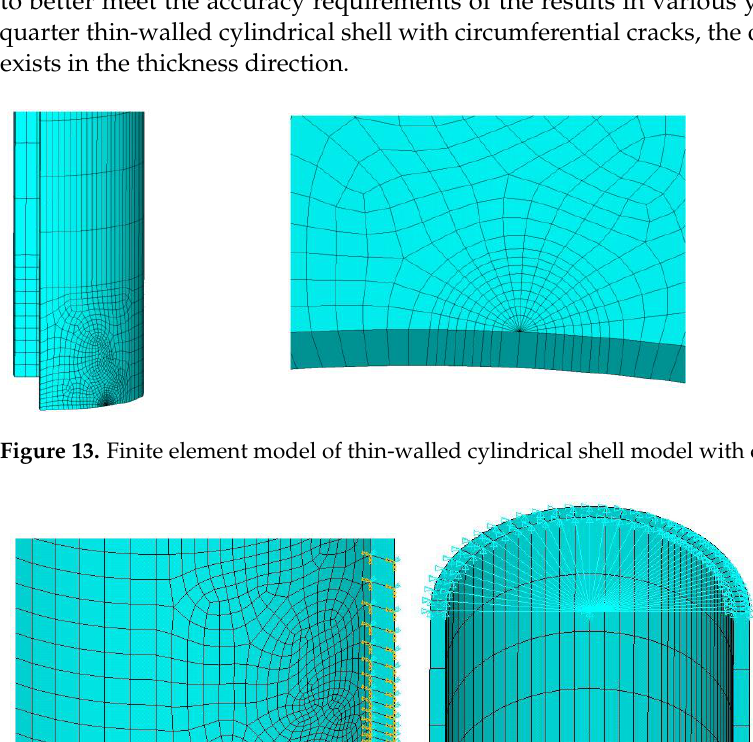
Figure 15. Finite element model of a thin-walled cylindrical shell model with an oblique crack. ( a ) Middle part of model, ( b ) Local area of model, ( c ) End region of model. Figure 14. S ymmetry surfaces and symmetry conditions for a circumferential crack.